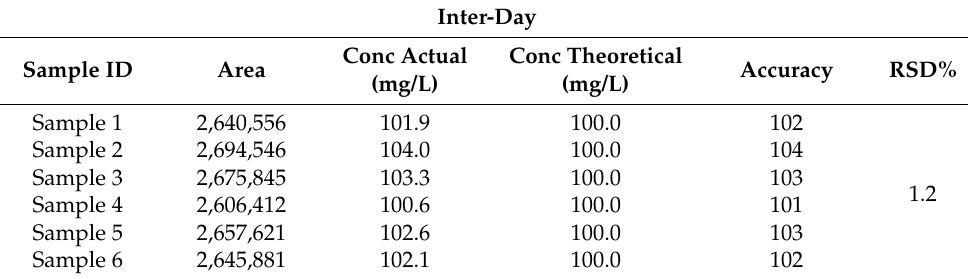
Table 6. Intermediate precision (Inter-day) of pantoprazole.